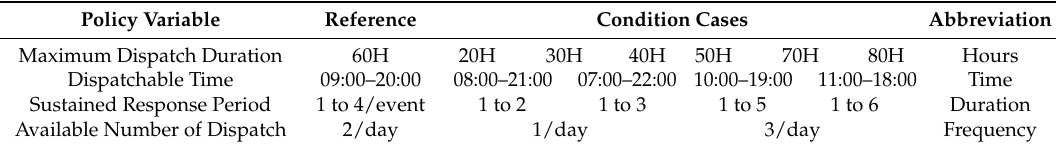
Table 3. The condition cases of each policy variable for sensitivity